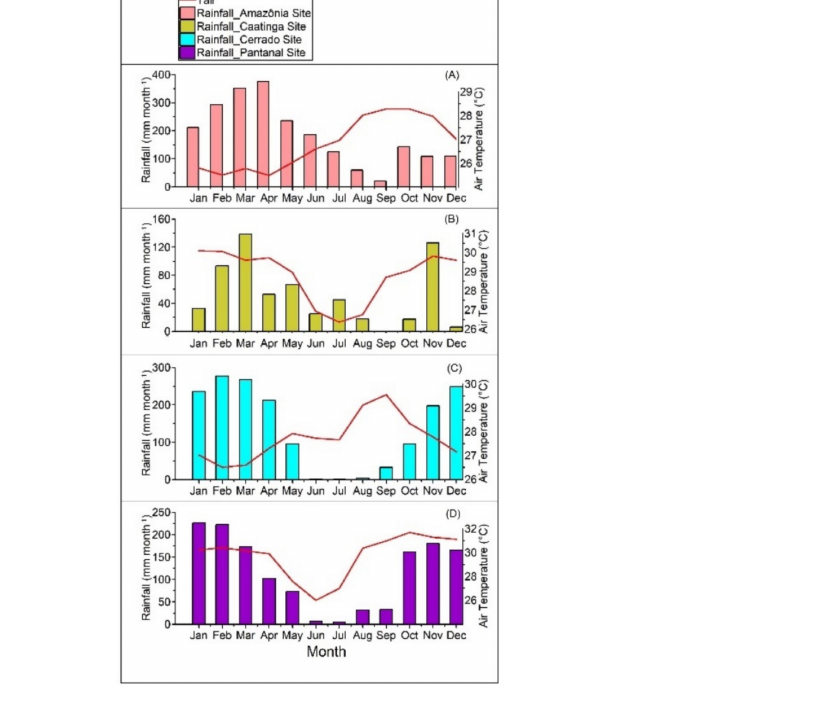
Figure 2. Monthly variation of mean air temperature (lines) and accumulated rainfall (bars) for each site and period: ( A )—Amazonia: 2009–2011 (rainfall from INMET station); ( B ) Caatinga: January 2014 − July 2015 (rainfall from INMET station); ( C ) Cerrado: 2004 − 2006; ( D ) Pantanal: 2015 −